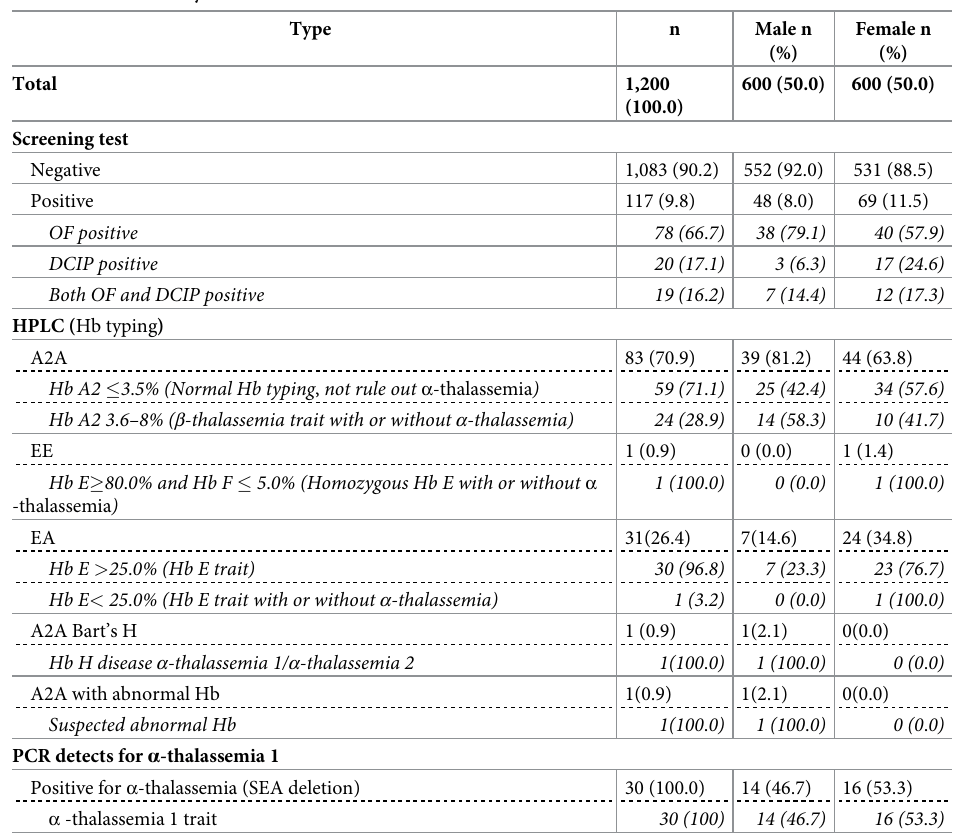
Table 6. All laboratory results.